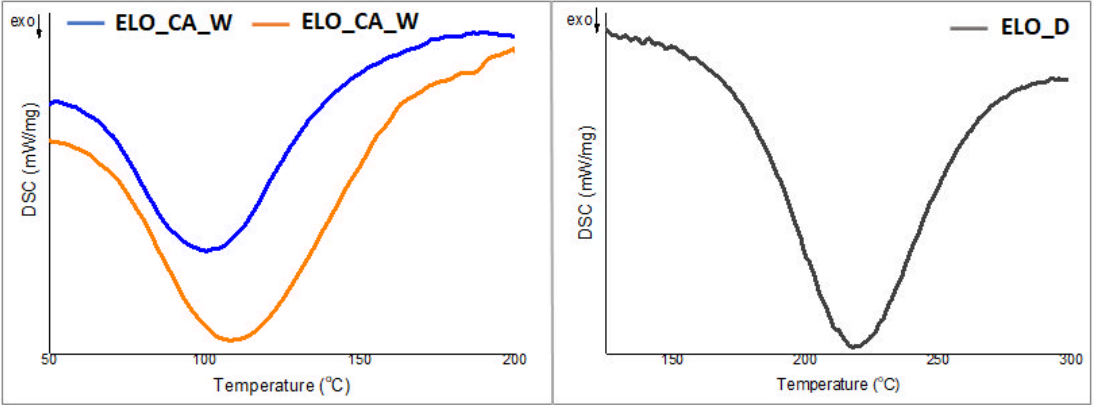
Figure 1. DSC thermograms for the initial bio ‐ based epoxy formulations.